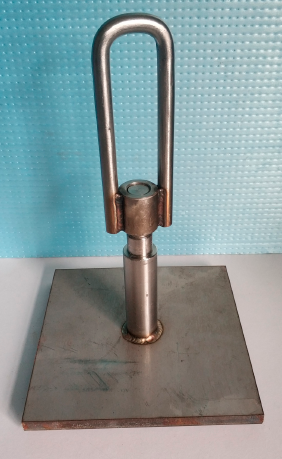
Figure A2. Bearing bracket.